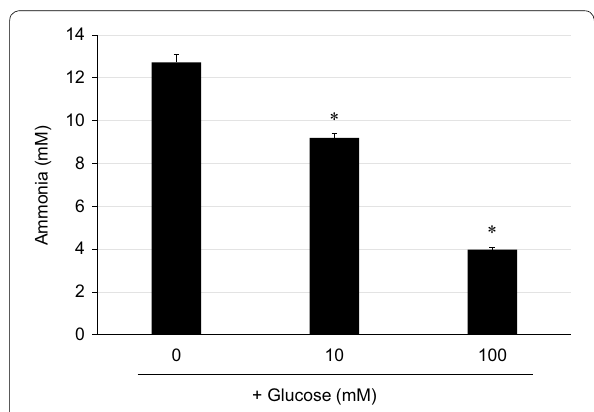
Fig. 3 Inhibitory effect of glucose on ammonia production by E. coli DH10B. E. coli DH10B was incubated in M9-yeast extract with or without glucose (10 or 100 mM) for 26.5 h to produce ammonia. Values are expressed as the mean significance was determined by Dunnett’s test (P < 0.001)